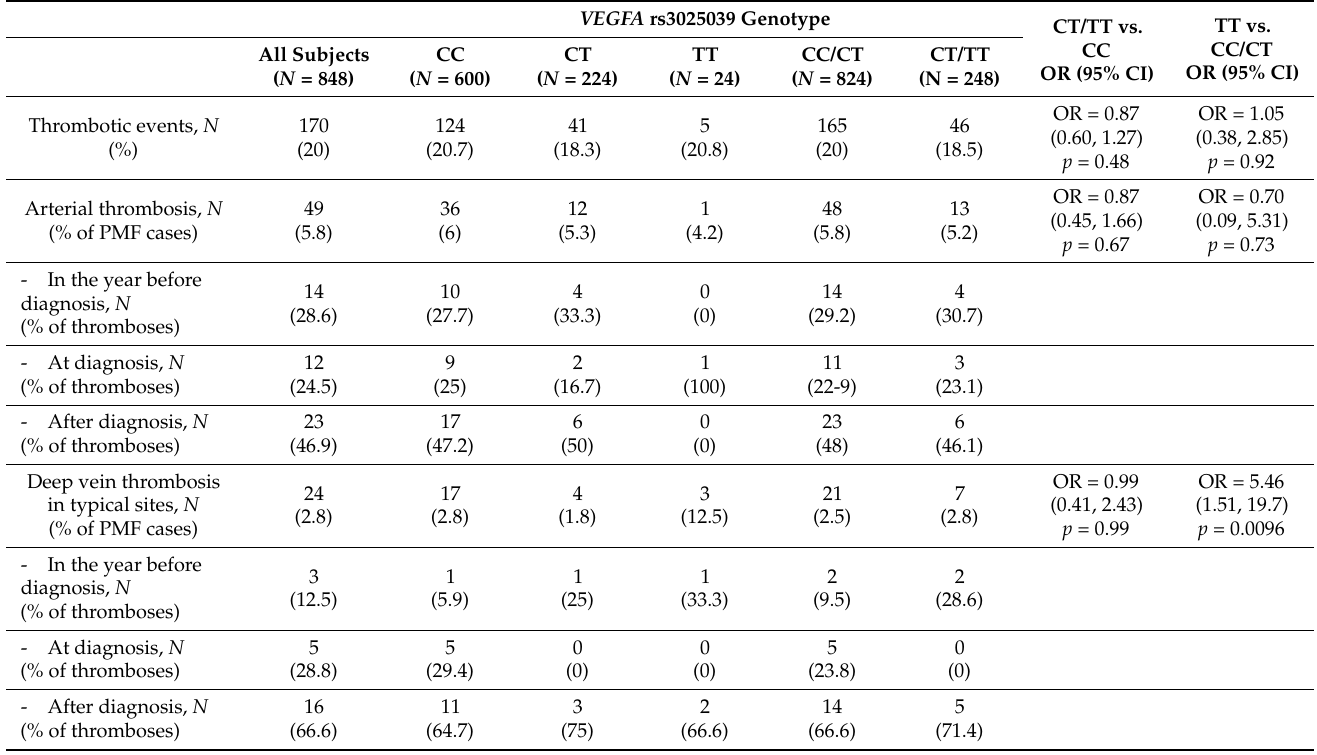
Table 4. Major thrombotic events stratified by the VEGFA rs3025039 genotype. VEGFA rs3025039 Genotype CT/TT vs.